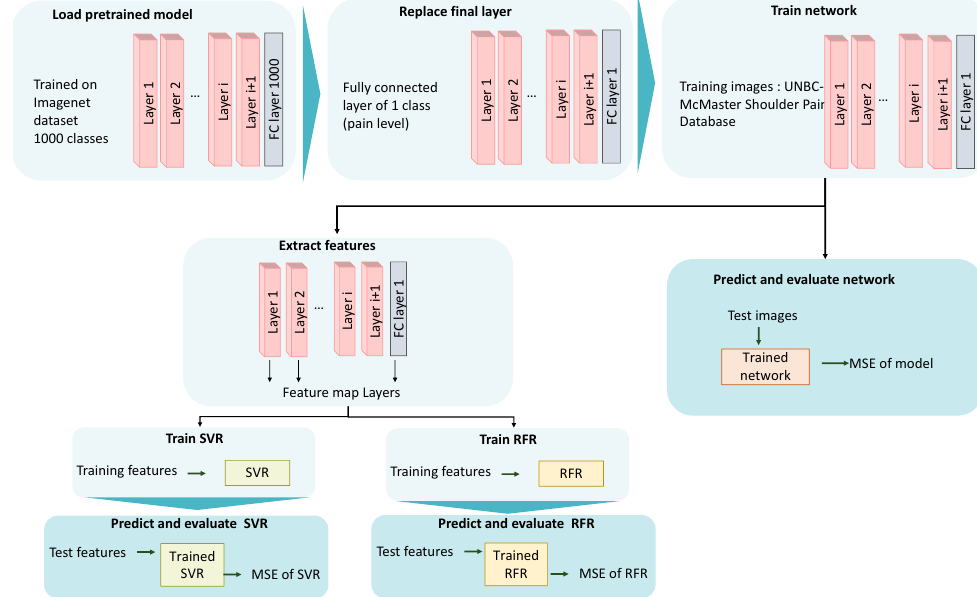
Figure 1. Proposed framework for pain